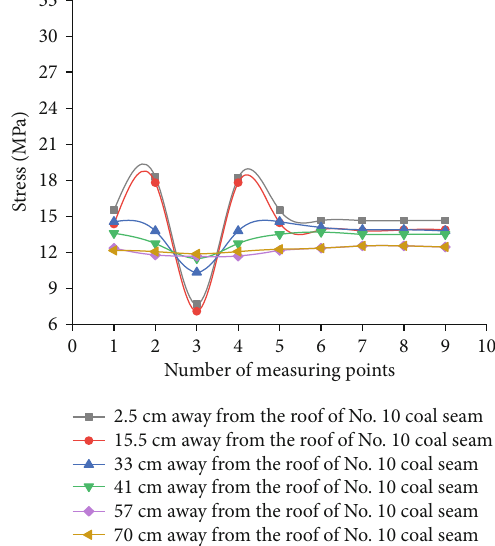
Figure 5: Stress diagram of working face mining at